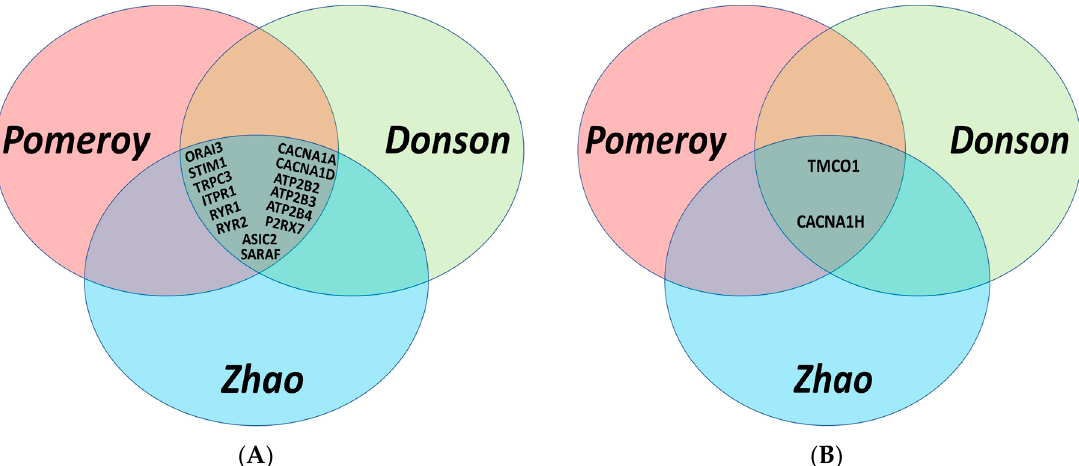
Figure 1. Venn diagrams illustrating the common genes with p -values < 0.01 that were differentially expressed in MB patients compared to normal brain tissues in three independent datasets; Pomeroy [17], Donson [18], and Zhao [19]: ( A ) Fourteen lower expressed genes in MB; ( B ) two higher expressed genes in MB.